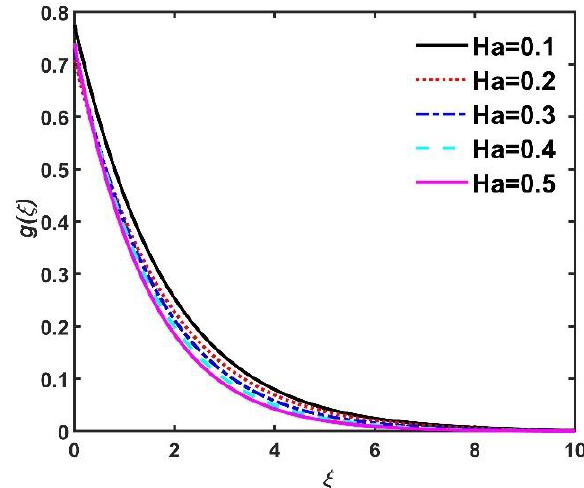
Figure 11. Impact of 𝐻𝑎 on 𝑔(𝜉) .